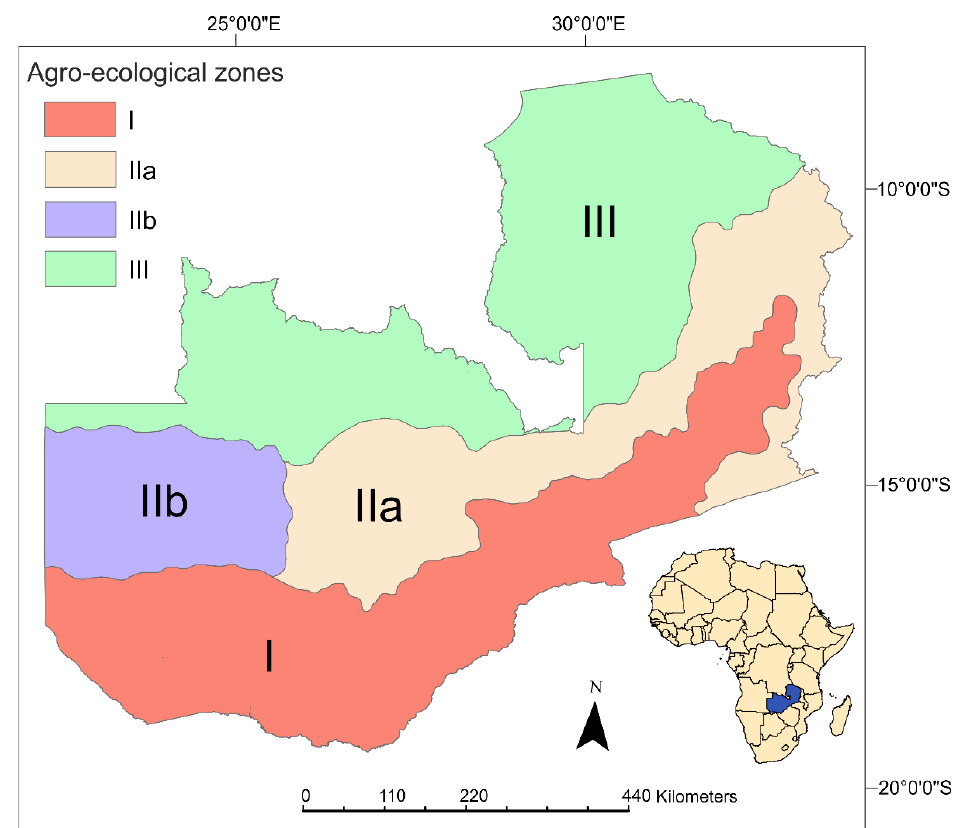
Figure 1. Agro-ecological zones of Zambia. The insert map shows the location of Zambia in the African continent.